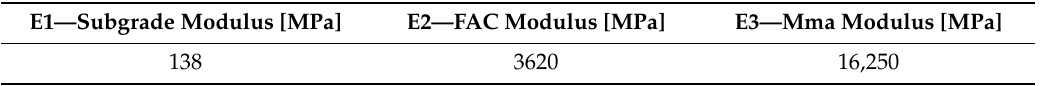
Table 7. List of identified modules for the temperature + 10 ◦ C.